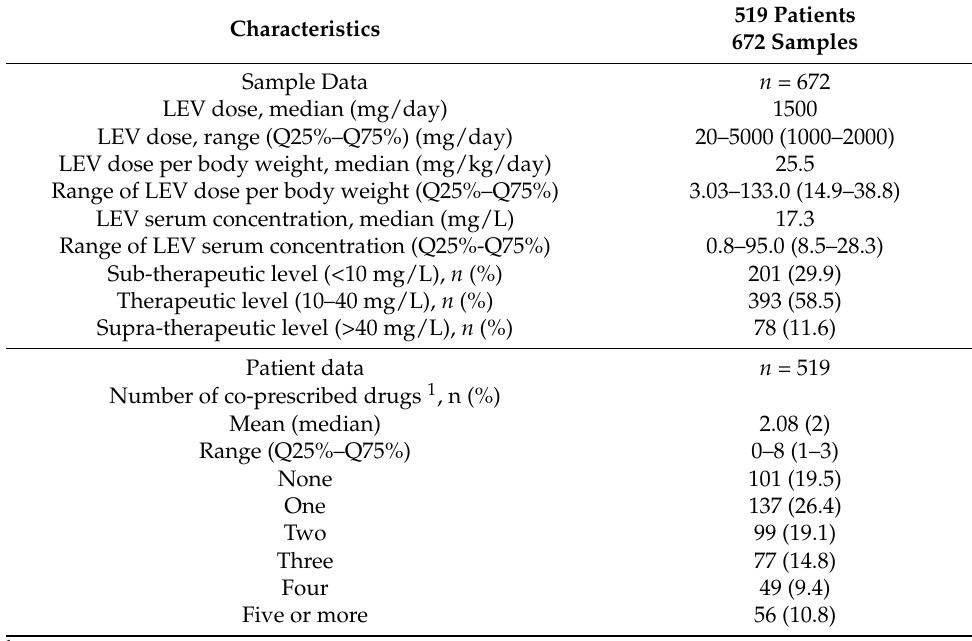
Table 2. Levetiracetam concentration and medication